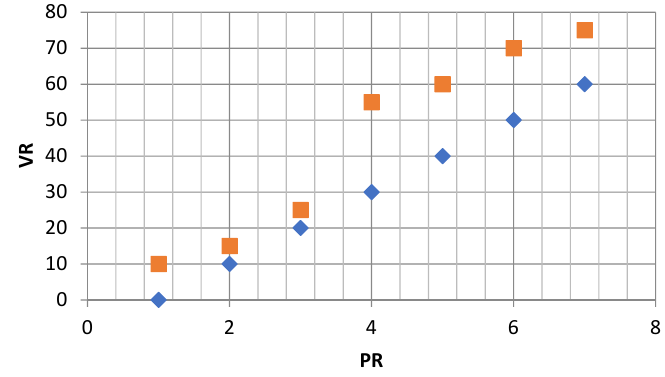
Figure 5. PR vs. Figure 5. PR vs. VR.